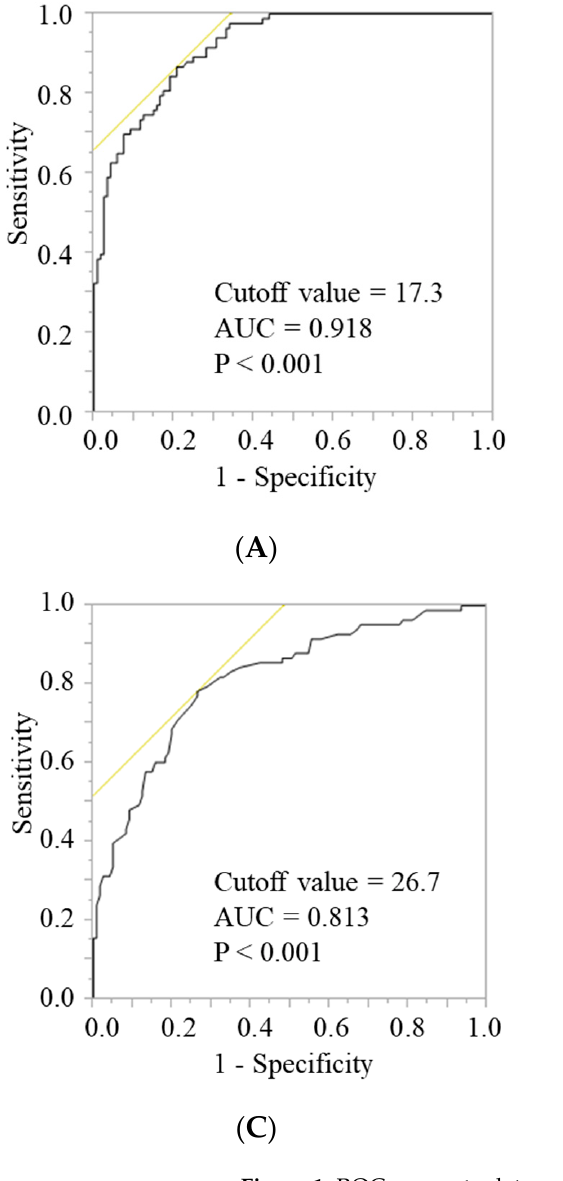
Table 2. Statistical evaluations of developed cutoff values for the FFMI and AC to discriminate the cutoff value for the SMI according to AWGS * in the validation group.